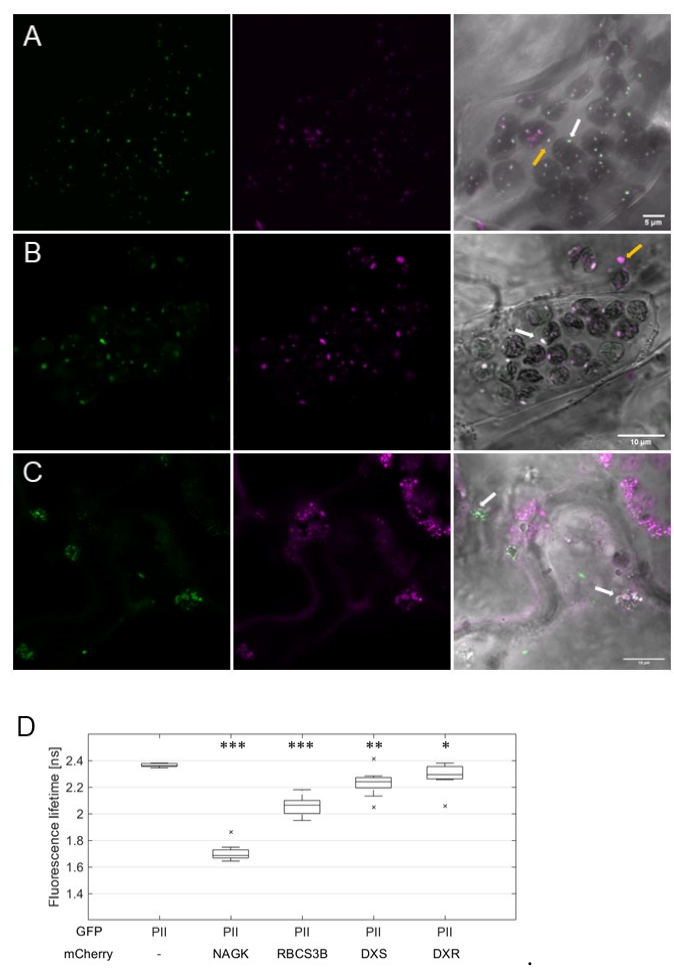
Figure 6. At PII is found in different plastidial aggregates. At PII-GFP was co-expressed with At RBCS3B-mCherry ( A ), At DXR-mCherry ( B ), and At DXS-mCherry ( C ), respectively, under the control of p35S in N. benthamiana . In each row, the GFP fluorescence is shown first, the mCherry fluorescence is shown second, and the merge of both fluorescence images with the brightfield image as background is shown last. White arrows mark exemplarily AtPII aggregates in chloroplasts (dark and round structures in the brightfield image), orange arrows indicate extraplastidic vesicle-like structures. ( D ) FLIM analyses of fluorescent co-localizing signals in ( A – C ) together with At PII-GFP/ At NAGK-mCherry as positive control. Student’s t -test used for calculation of significance. Data points marked with an “x” represent statistical outliers of measurement. * p < 0.05; ** p < 0.01; *** p < 0.001.